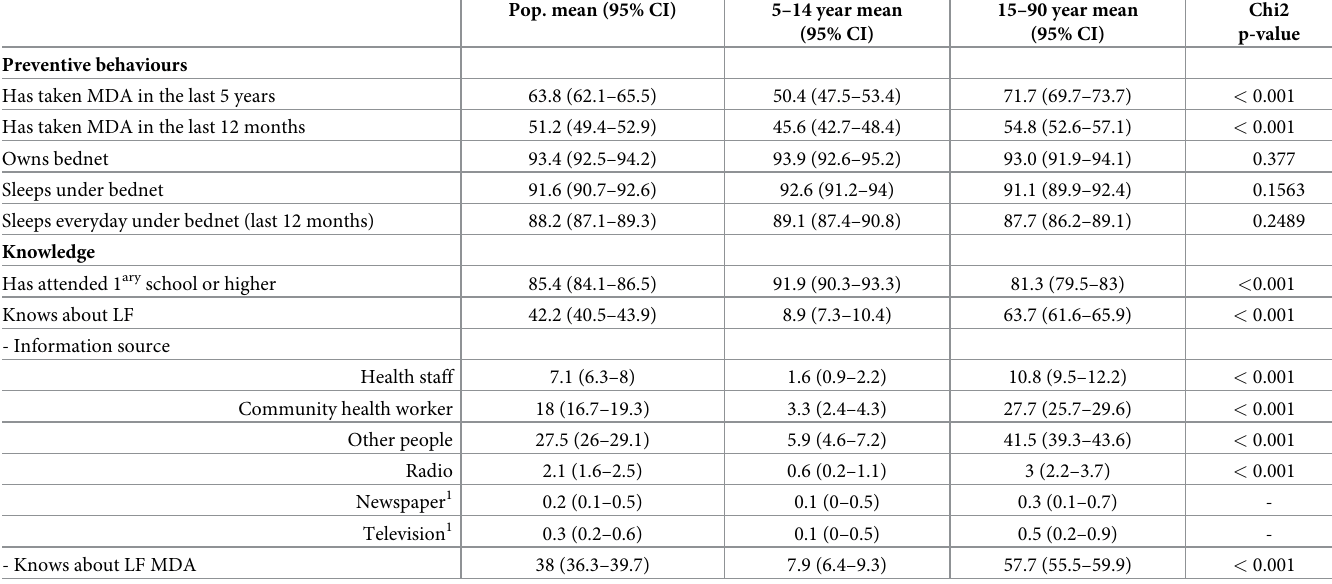
Table 4. Knowledge, attitudes and practices (KAP) related to LF transmission in sentinel and spot-check sites of Manakara Atsimo, Mananjary, Vohipeno and Ifa- nadiana districts (N =